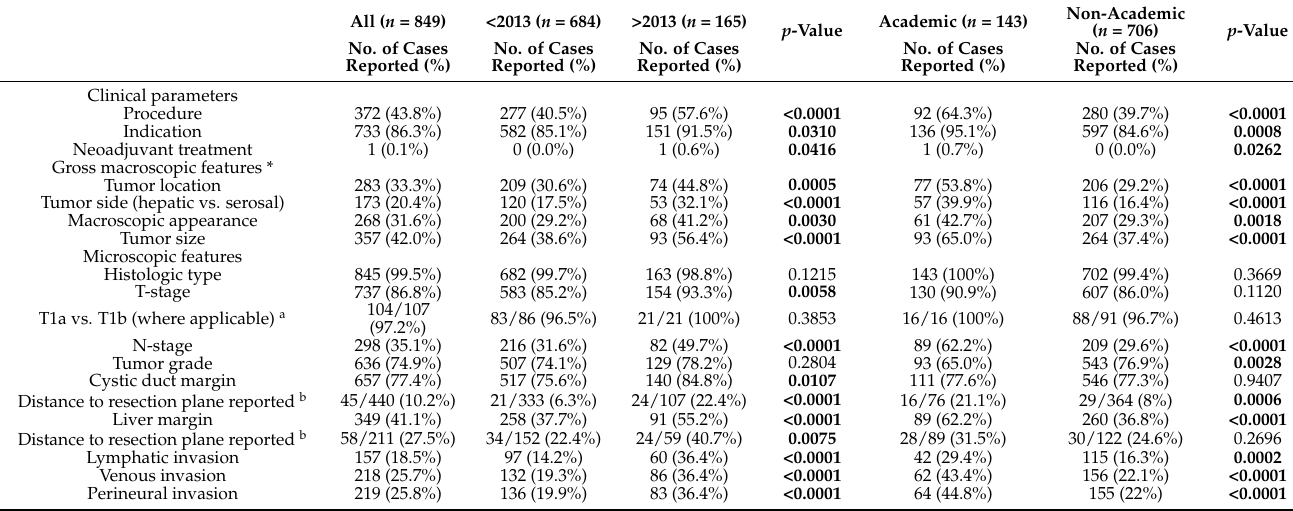
Table 1. Completeness of GBC pathology